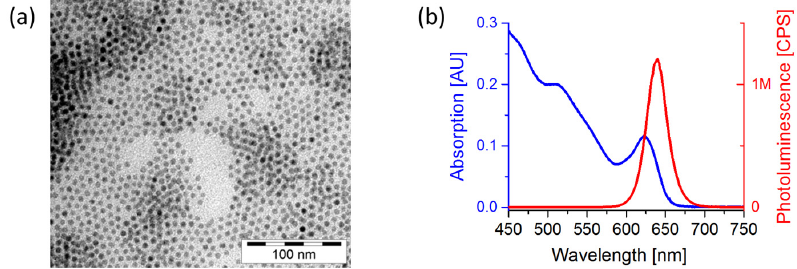
Figure 2. ( a ) Transmission electron microscopy (TEM) image of CdSe nanocrystals (NCs) used for the investigation from a 100:3:2 (hexadecylamine/trioctylphosphine oxide):(cadmium-stearic acid):(trioctylphosphine-selenid) ((HDA/TOPO):(Cd-SA):(TOP-Se)) ratio, synthesized for 30 min at 300 ˝ C by wet-chemical hot injection NC synthesis with an average diameter of 6.5 nm. ( b ) Ultraviolet-visible (UV-Vis) absorption spectrum (blue line) and photoluminescence spectrum of CdSe nanocrystals (NCs) synthesized by a hot injection method recorded at an excitation of 575 nm (red line).